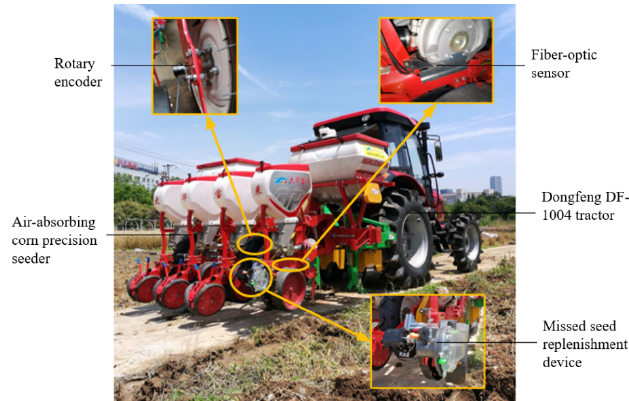
Figure 13. Field experiment site.